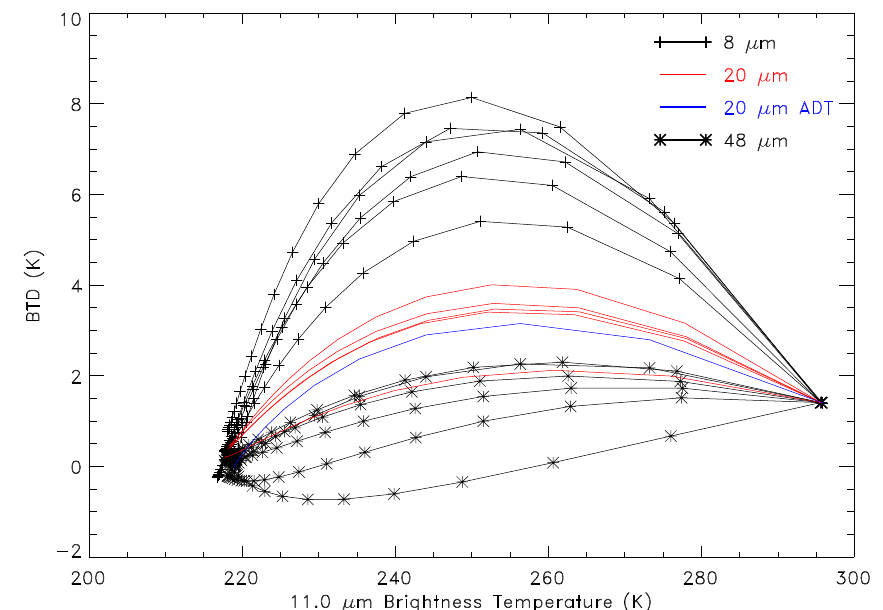
Fig. 1. Theoretical split-window arches for ice clouds composed of six different ice crystal habits (randomized aggregates, smooth aggregates, rough aggregates, solid hexagonal columns, and bullets (Yang et al., 2000) and spheres assuming anomalous diffraction theory) with a cloud temperature of 210K. Calculations are shown for three different effective radius (8µm, 20µm, and 48µm) for each ice crystal type. Each symbol along a given line represents an increment of 0.5 in cloud optical depth, ranging from 0 at the right arch base to 10 at the left arch